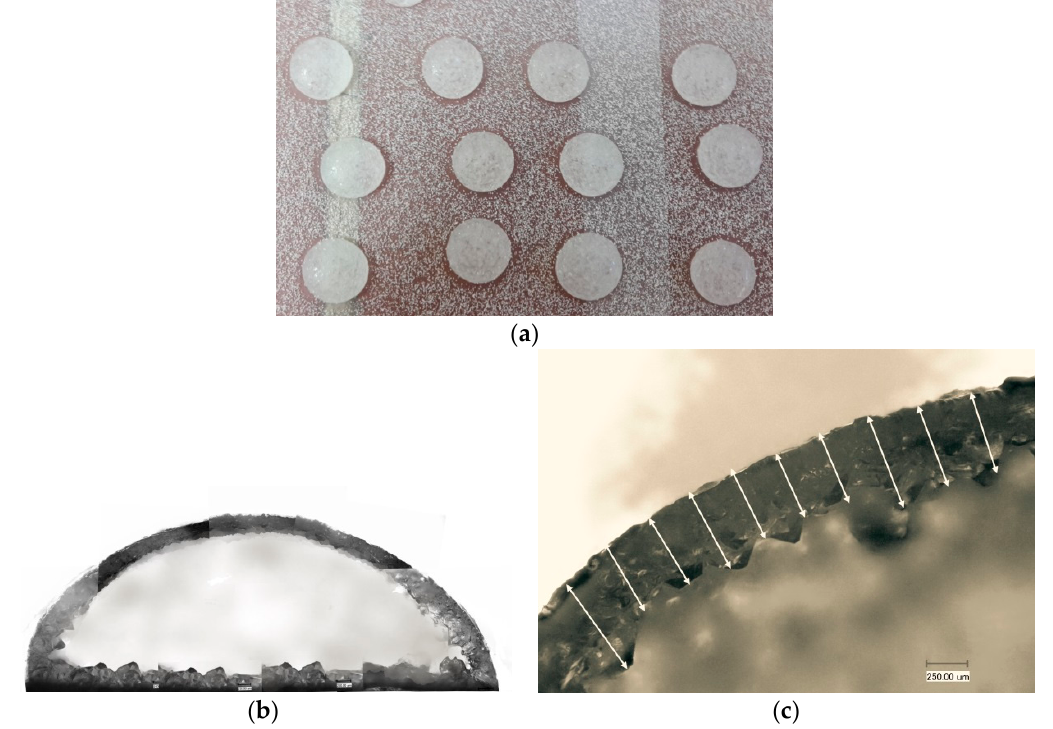
Figure 1. ( a ) Drop formed pastilles with coated active pharmaceutical ingredients; ( b ) Crystalline coat of the pastilles (cross section); ( c ) Layer thickness measurement of a pastille cross section.